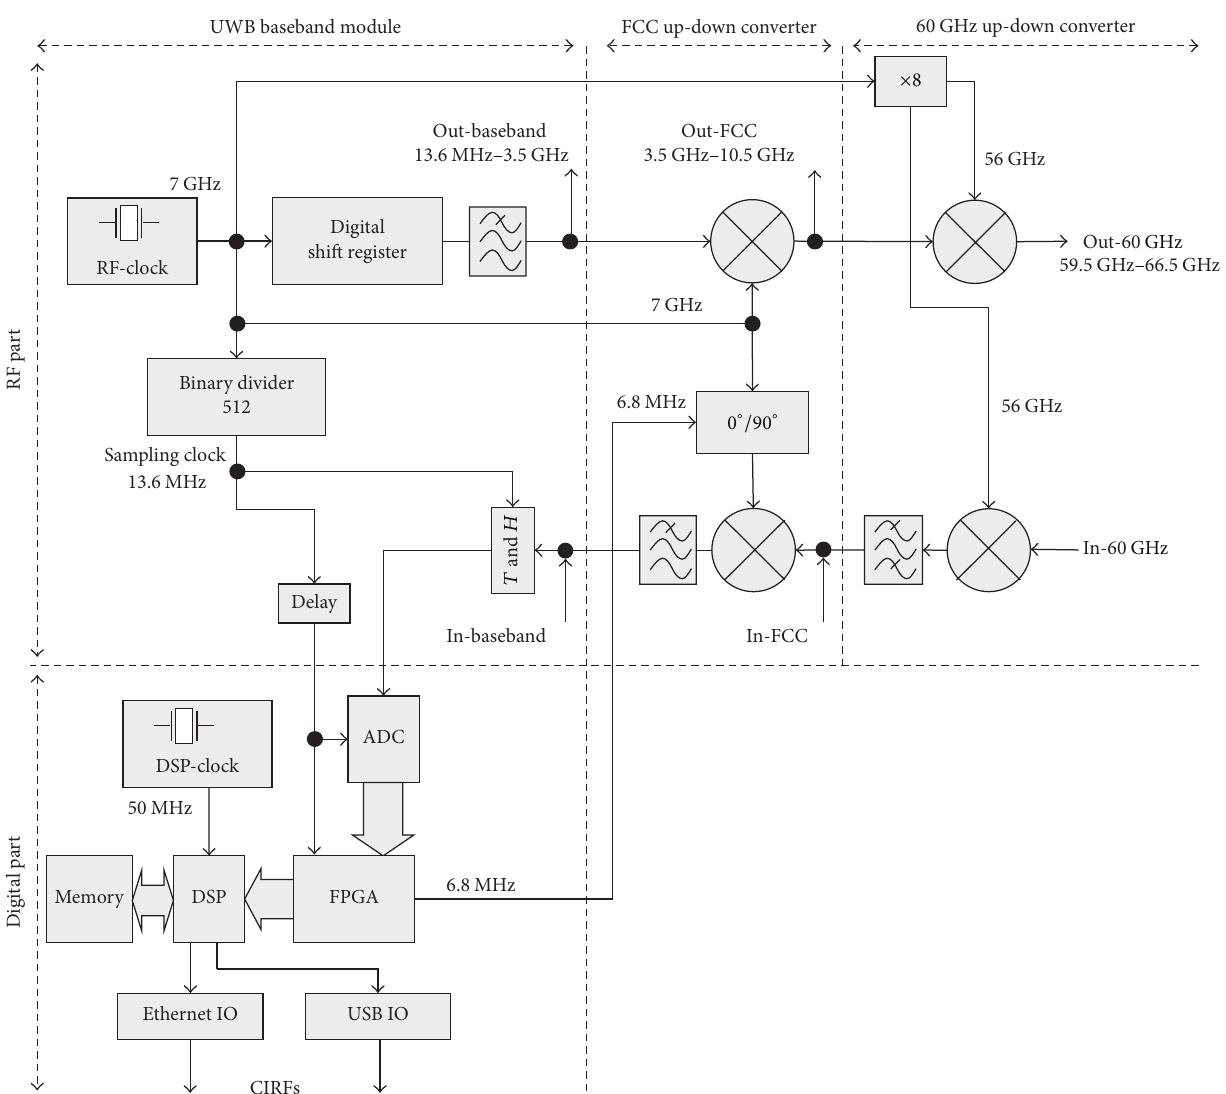
Figure 1: Architecture of the UWB channel